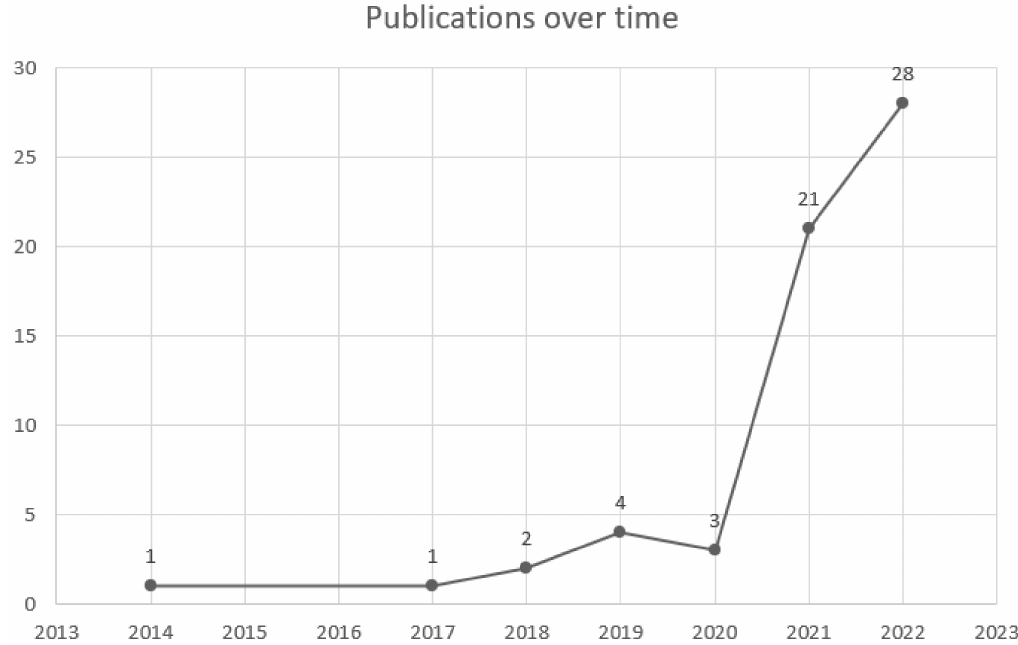
Figure 3. Publication date against article count.